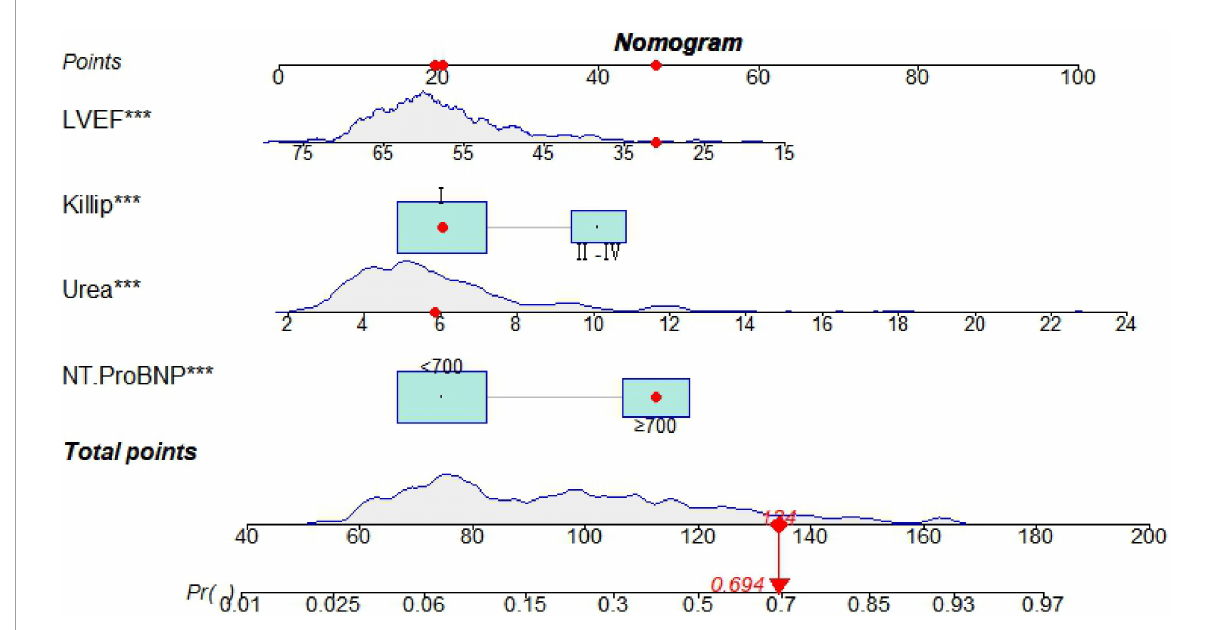
FIGURE2 A nomogram predicting in-hospital major adverse cardiovascular events (MACE) after percutaneous coronary intervention (PCI) in patients with ST-segment elevation myocardial infarction (STEMI). *** P < 0.05.